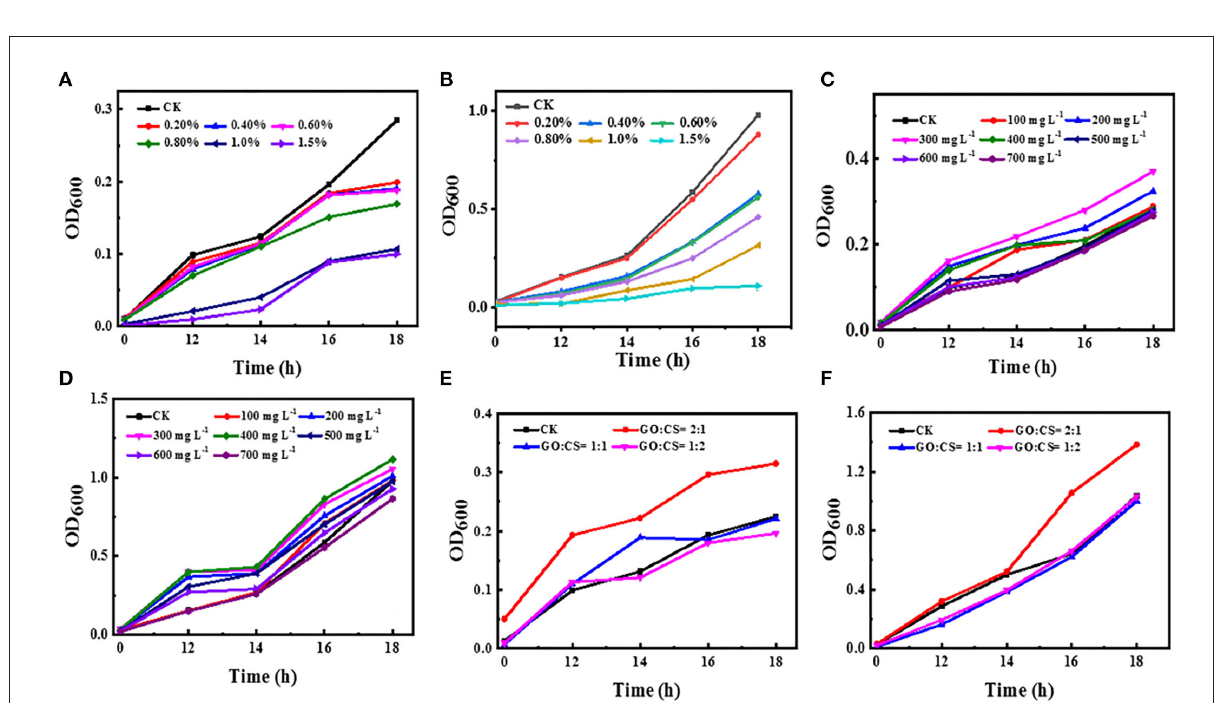
FIGURE2 Effect of different concentrations of chitosan (A,B) , different concentrations of GO (C,D) , and different ratios of GO:CS (E,F) , respectively, compared to control (CK) on BC and PAO1.